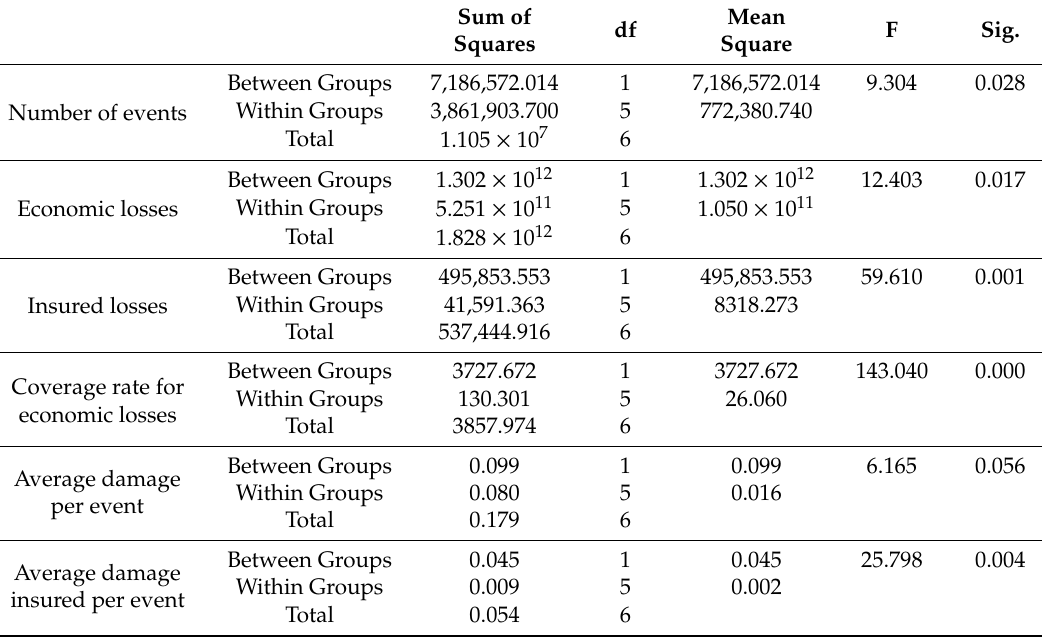
Table 4. ANOVA for the group before / after